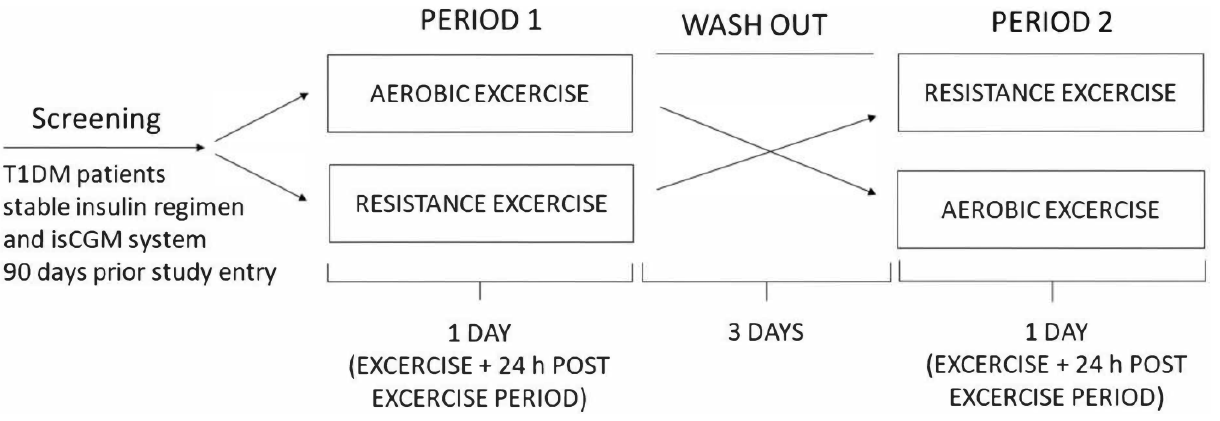
Figure 1. Study design